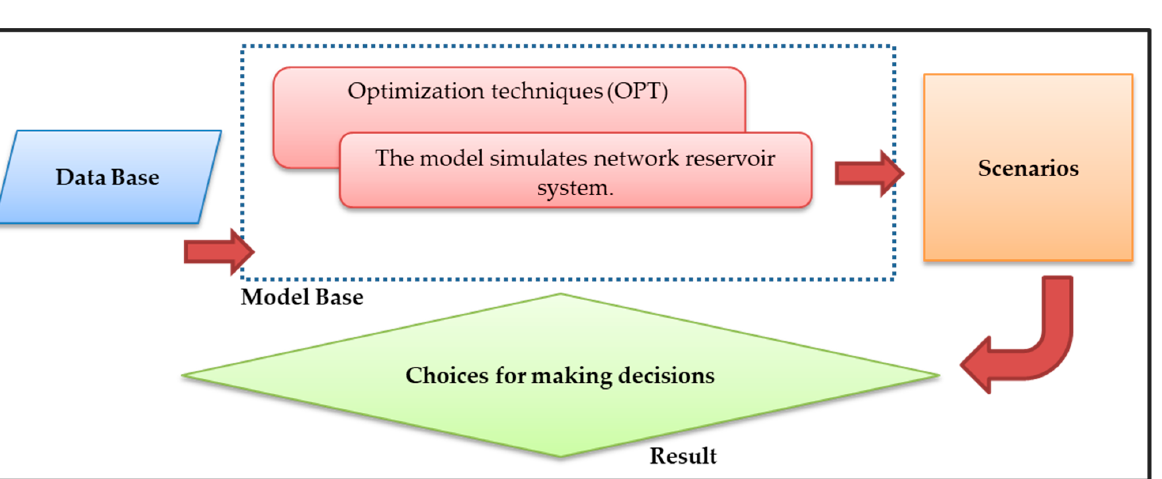
Figure 3. Historical inflow and average downstream water requirements of the Bhumibol and Sirikit reservoirs.